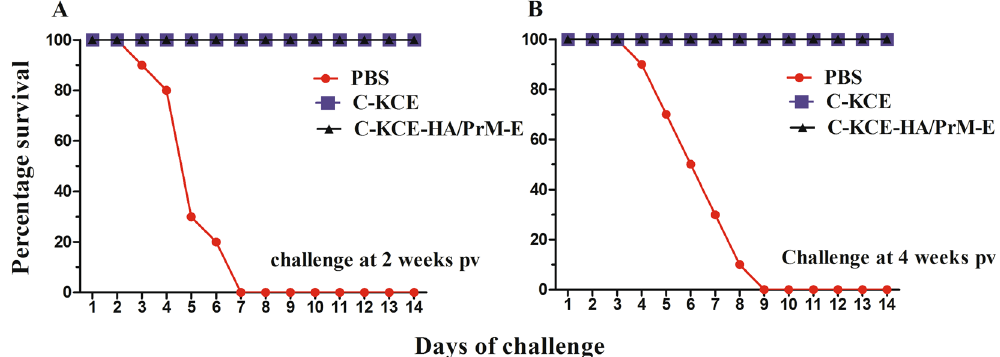
Figure 3. Conferred protection from immunization of ducks with C-KCE-HA/PrM-E against virulent DEV challenge. Ducks were inoculated subcutaneously with 10 5 PFU of C-KCE-HA/PrM-E, 10 5 PFU of C-KCE, or PBS (n = 10 per group) as a control, then intramuscularly challenged with 100-fold duck lethal dose (DLD) 50 HB/10 at 2 weeks ( A ), 4 weeks ( B ) post-vaccination (pv), respectively. Ducks were examined daily for 2 weeks after challenge.